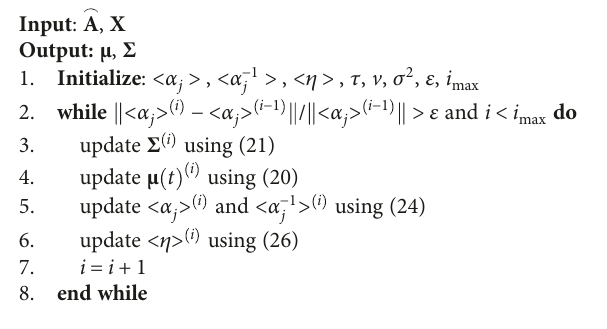
Algorithm 1: The main steps of the model parameter